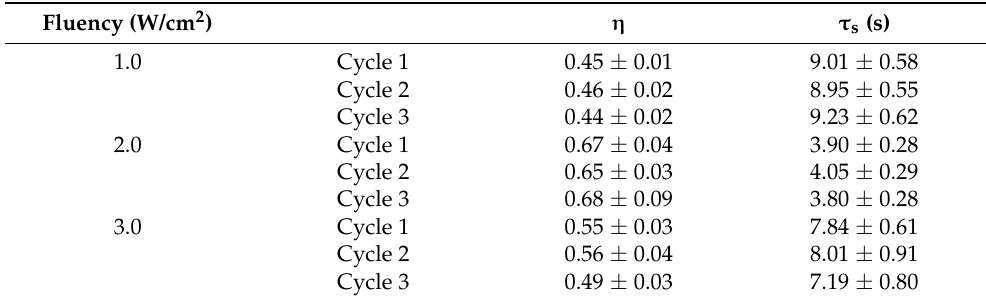
Table 1. Photothermal conversion efficiency and relaxation time of PSS/PLL/HA-coated AuNRs after the different irradiation cycles at different